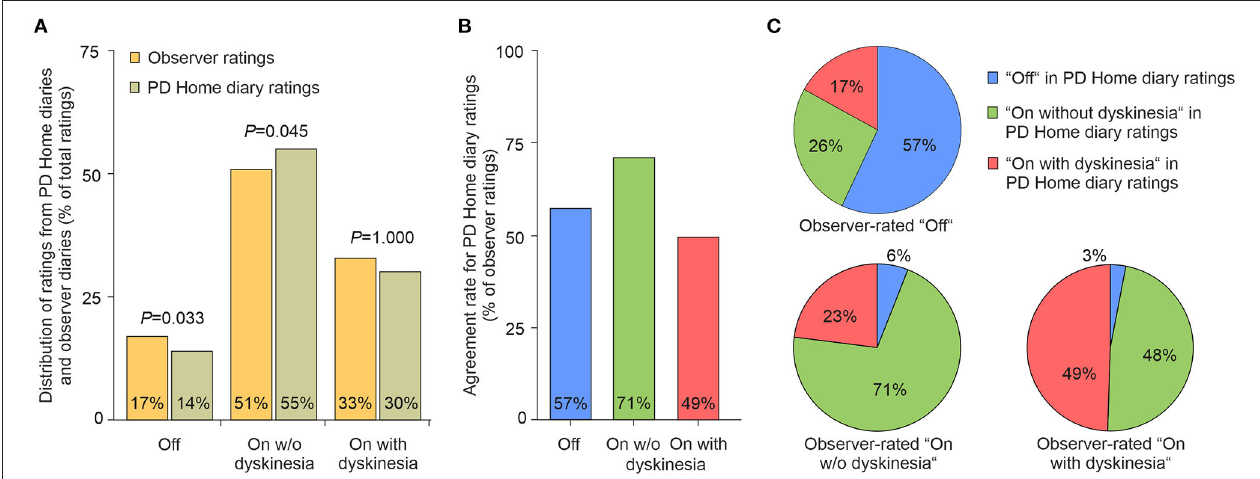
FIGURE 1 | Proportion and temporal agreement of motor states assessed by observer diaries and PD Home diaries. (A) Proportion of “Off”, “On without dyskinesia” and “On with dyskinesia” as assessed by observer and patient diaries. P -values are from post-hoc McNemar test with Bonferroni adjustment. (B) Temporal agreement rate for all motor states as well as “Off”, “On without dyskinesia” and “On with dyskinesia” with the observer ratings as the reference for comparison. (C) Participants’ choices on the PD Home diary in each respective observed motor state. Number of observations in each observed motor state: “Off”: n dyskinesia”: n 651, “On with dyskinesia”: n 419. PD, Parkinson’s = =